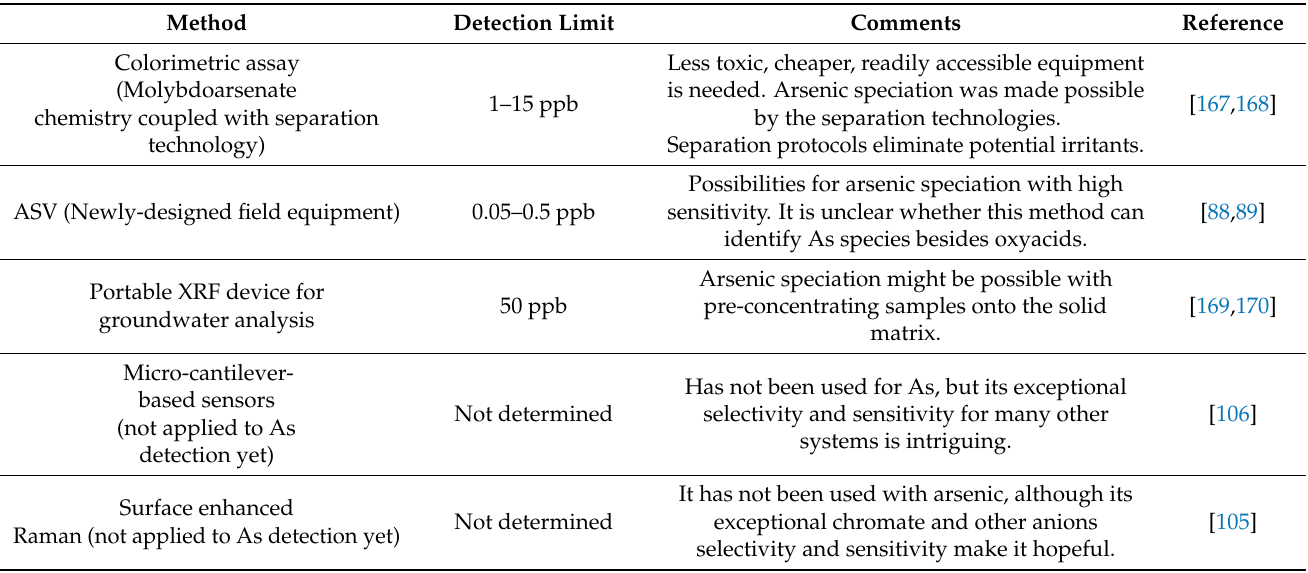
Table 17. Efforts for the development of detection methods of As for future research